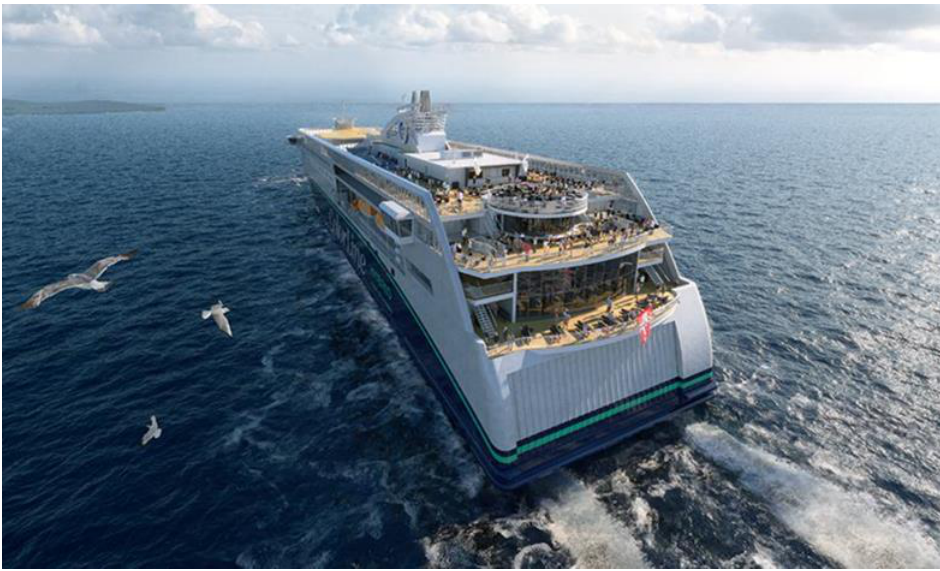
Figure 6. Color Hybrid, the world’s largest plug-in hybrid vessel [55].